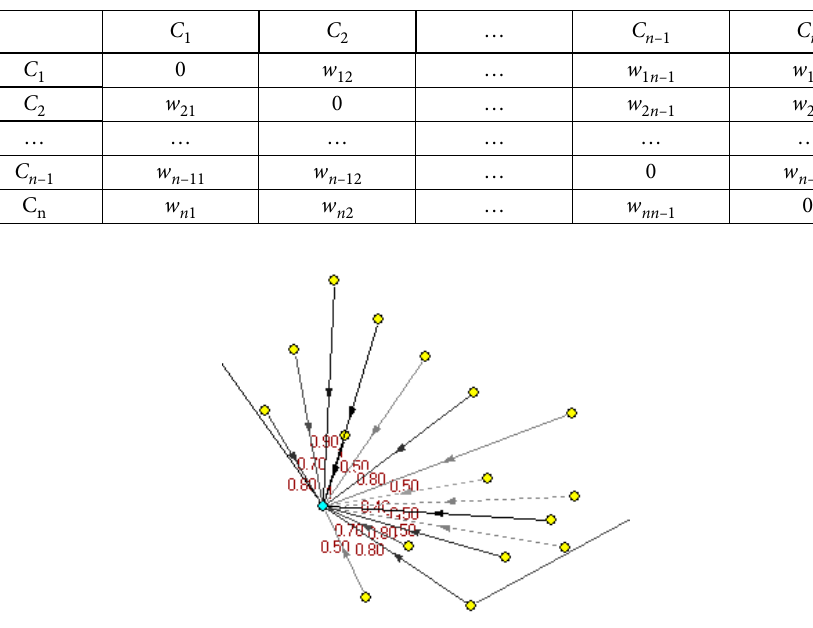
Figure 4. Analysis of degrees of intensity for entrepreneur